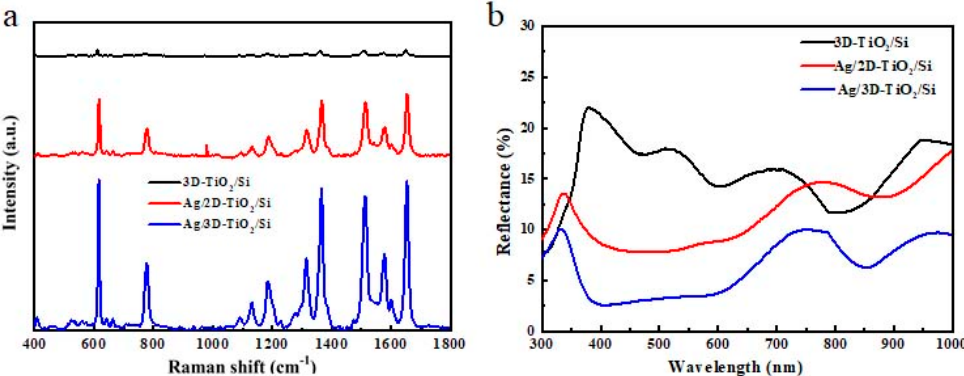
Figure 3. ( a ) Raman spectra of R6G on the different substrates; ( b ) reflectance spectra of the different